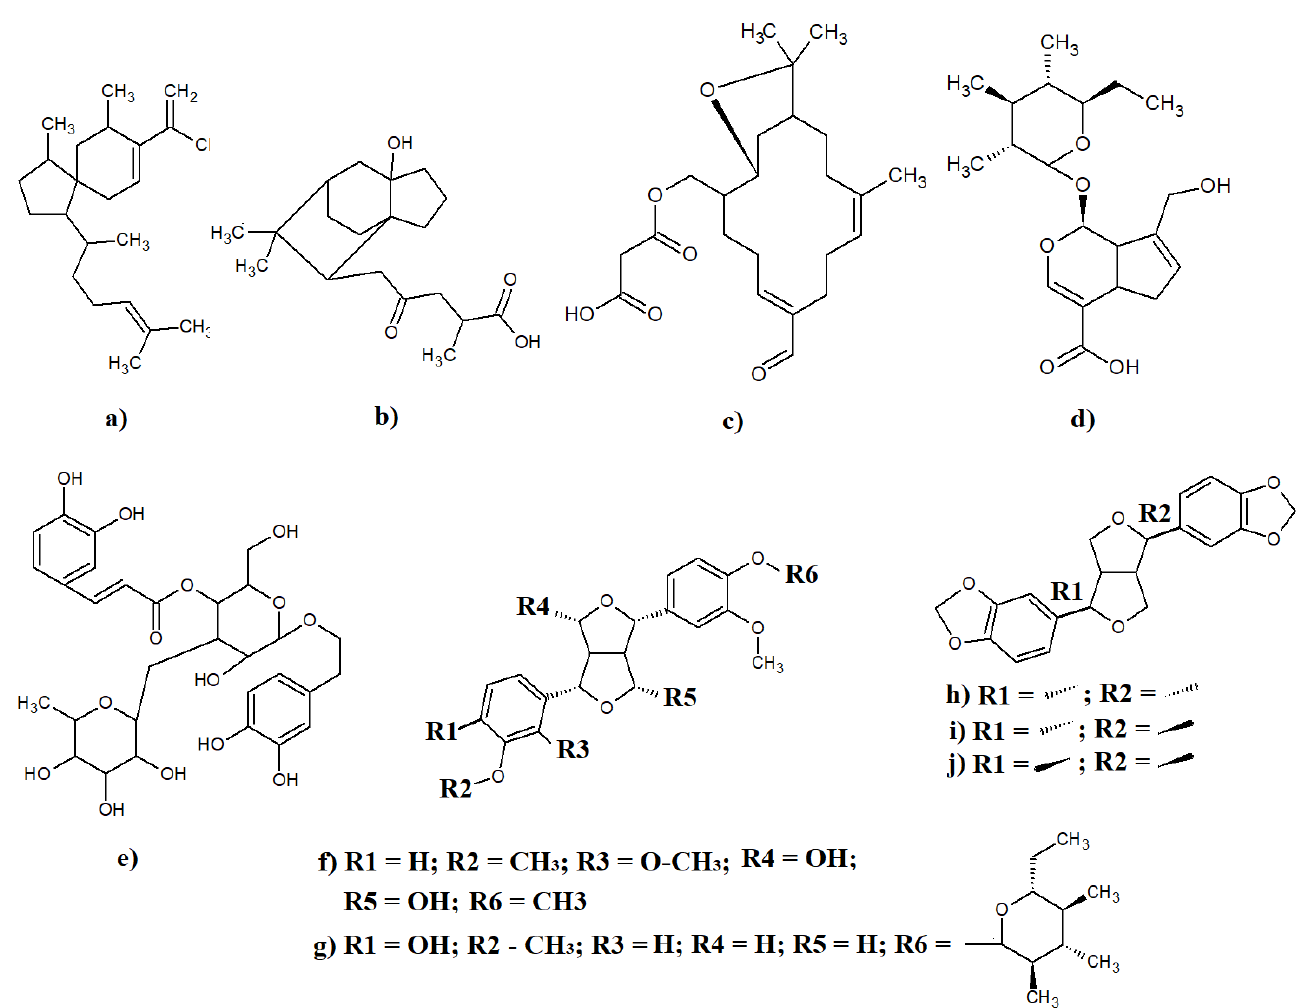
Figure 6. Non-serrulatane diterpenoids and other selected phytochemicals identified in Eremophila spp.: ( a ) 5 α-hydroxyviscida-3, 14-dien-20-oic acid; ( b ) -béta-hydroxy- 16-oxoereman- 19-oic acid; ( c ) 15- epoxy- 19-oxocembra-7,11 -dien- 18-ol; ( d ) geniposidic acid; ( e ) verbascoside; ( f ) epieudesmin; ( g ) pinoresinol-4-Oβ-D-glucopyranoside; ( h ) sesamin; ( i ) episesamin; and ( j ) aptosimon.